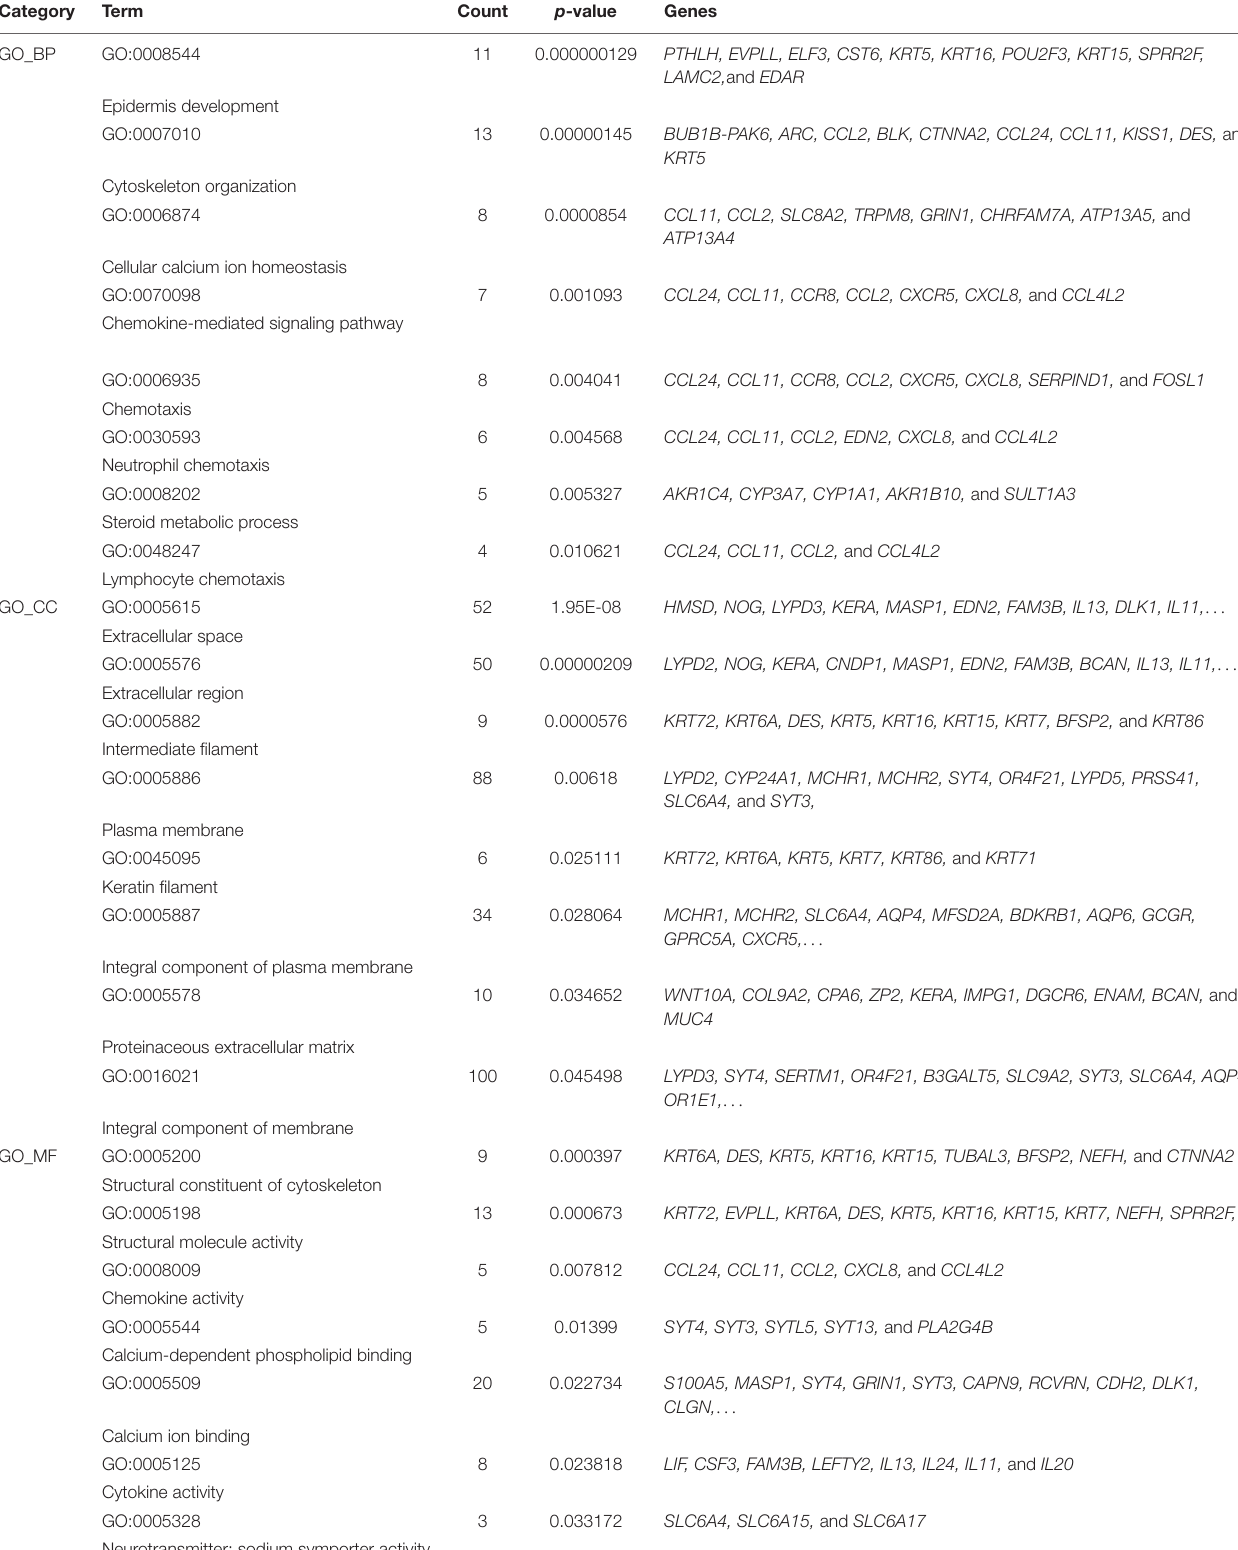
TABLE 2 | The significant GO enriched analysis of differentially expressed genes in